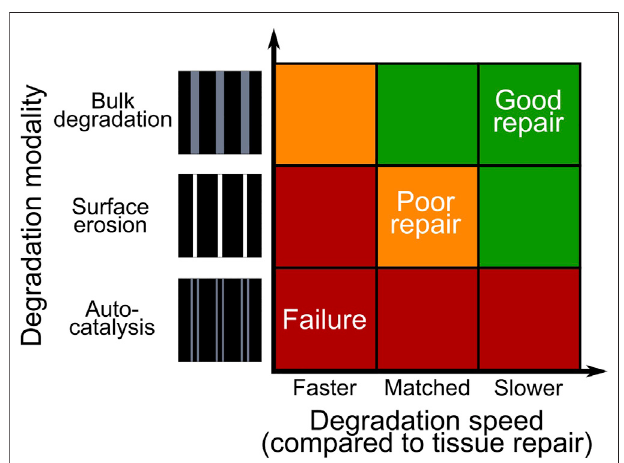
FIGURE 6 | Summary of the tissue repair outcomes obtained by simulating the degradation of a synthetic polymeric scaffold with strut-like architectureimplanted inanosteochondral defect. Thecolorsred,yellow,and green indicate mechanical failure, poor repair, and good repair,